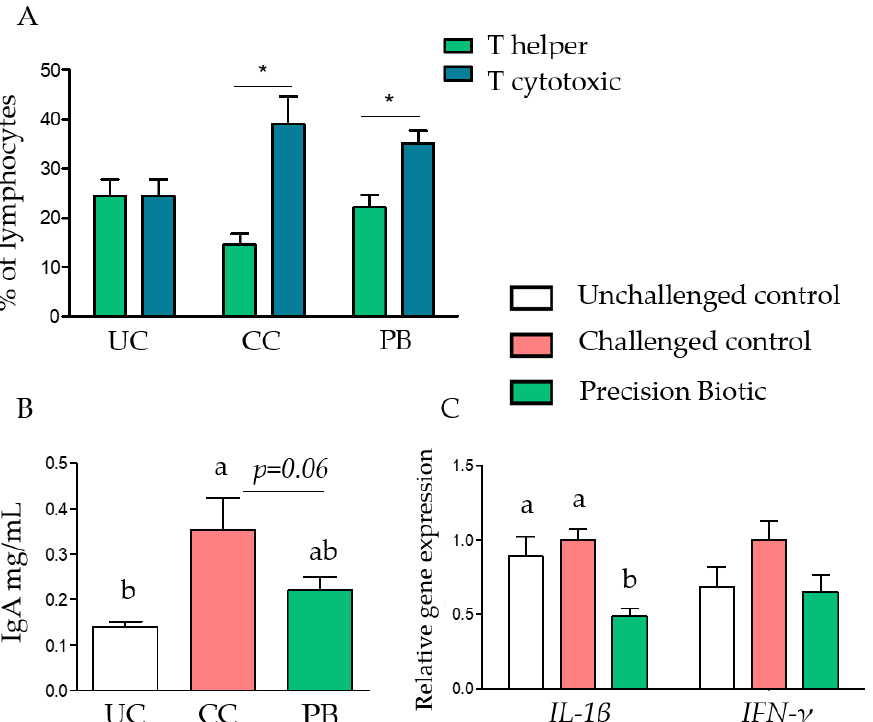
Figure 3. Intestinal inflammation was attenuated by dietary precision biotic at 28 days of age. ( A ) T helper (CD4) and T cell cytotoxic population counts in intestinal tissue samples as a percentage of total lymphocytes in broiler chickens. ( B ) IgA concentrations in plasma measured by ELISA. ( C ) Relative gene expression of IL-1 β and IFN- γ in ileal mucosa of broiler chickens. One-way ANOVA with Tukey post-hoc test has been performed on all results; statistically significant differences ( p < 0.05) are indicated by different letters or stars on the bars and trends are indicated by p -values. UC: unchallenged control; CC: challenged control; PB: precision biotic.